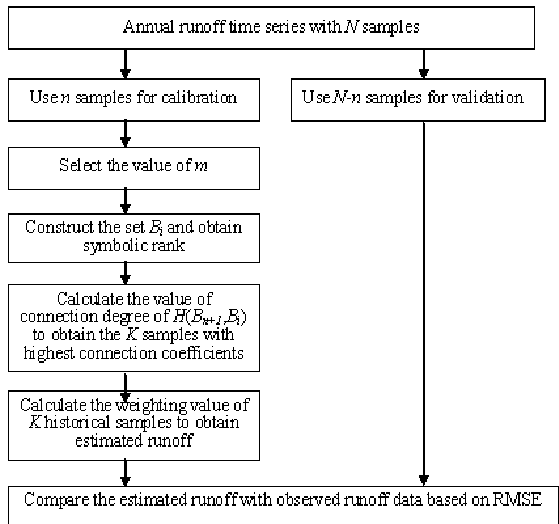
Figure 1. The flowchart for the forecasting processes of the set pair analysis-based similarity forecast (SPA-SF)